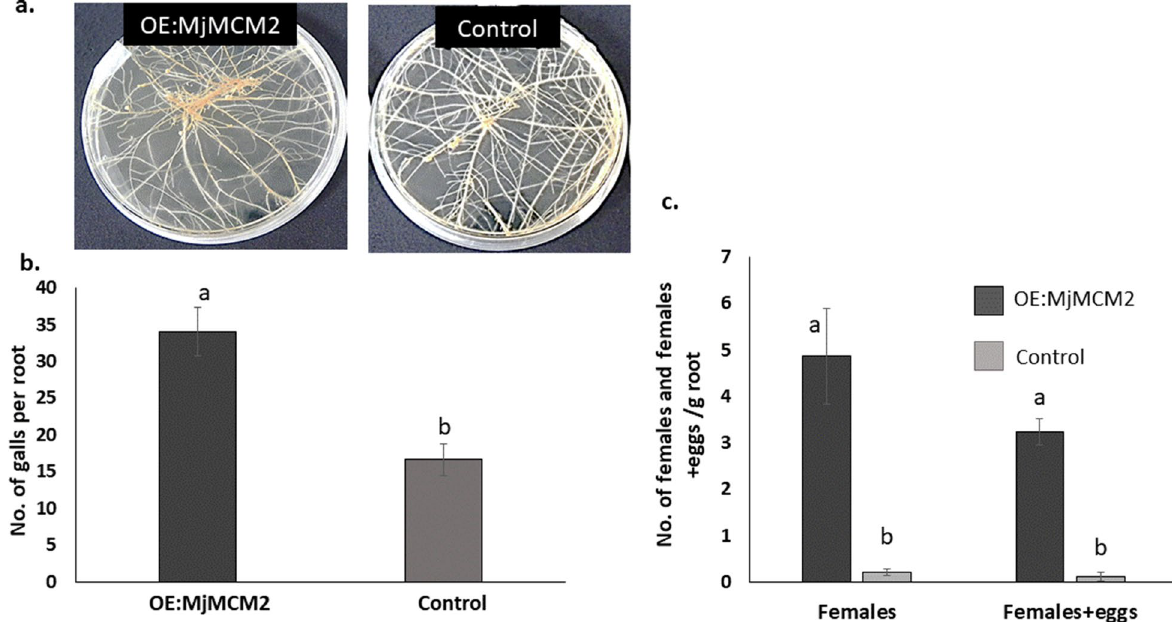
Figure 5. MjMCM2- overexpressing tomato roots are highly responsive to nematode infection. ( a ) Nematode- infected transgenic tomato hairy roots overexpressing MjMCM2 ( MjMCM2 OE ) and control roots at 28 DAI. ( b ) Mean number of galls counted on respective root systems at 28 DAI. ( c ) Means of dissected females and females + eggs per gram of tomato hairy root lines overexpressing MjMCM2 (dark gray) compared to a control line in which roots were transformed with empty vector (light gray). Roots were inoculated with 200 M. javanica juveniles. Different letters above the bars denote a significant difference ( P < 0.05, ANOVA) between the